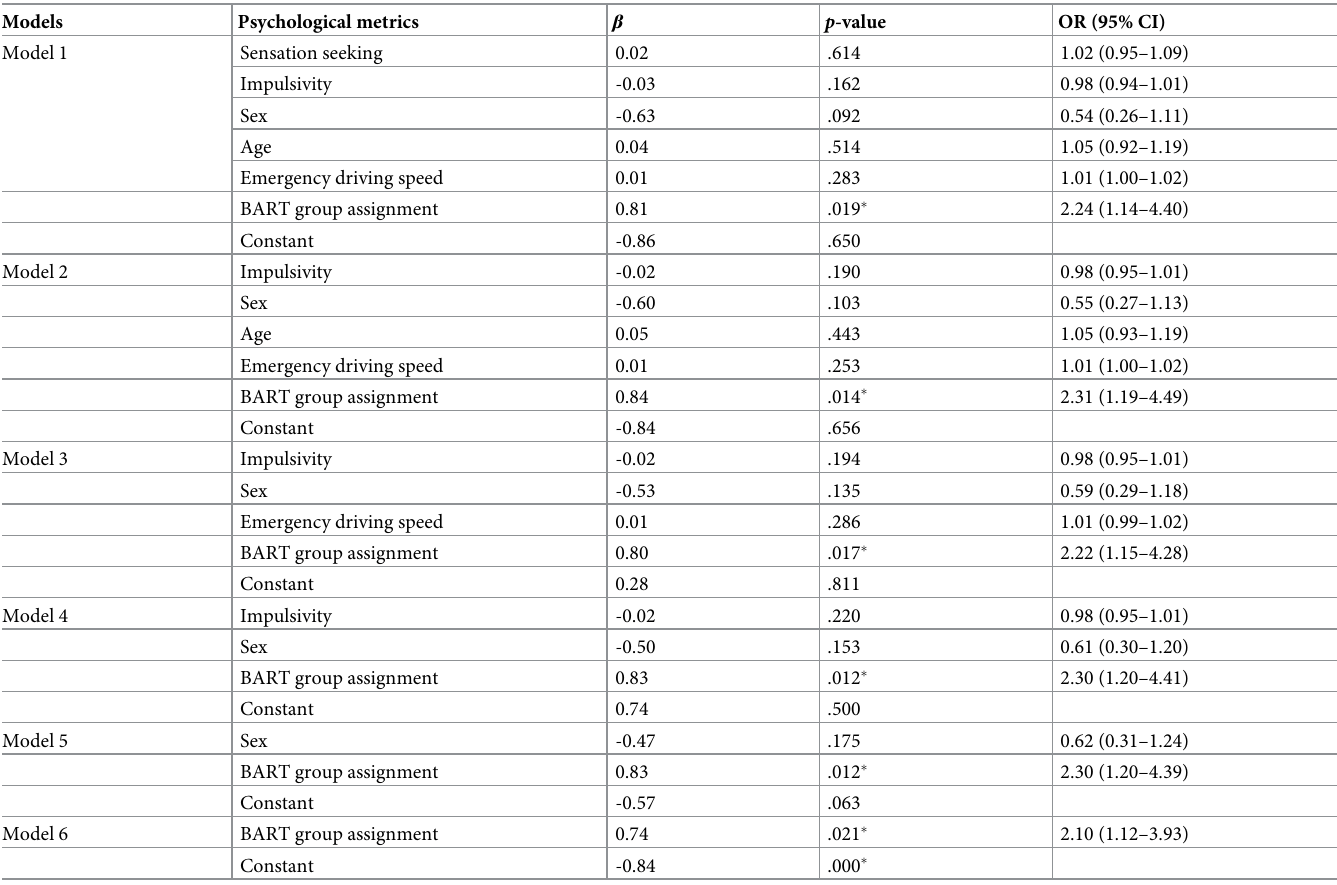
Table 5. Logistic regression results for predicting risky decision-making in the emergency situation from psychological